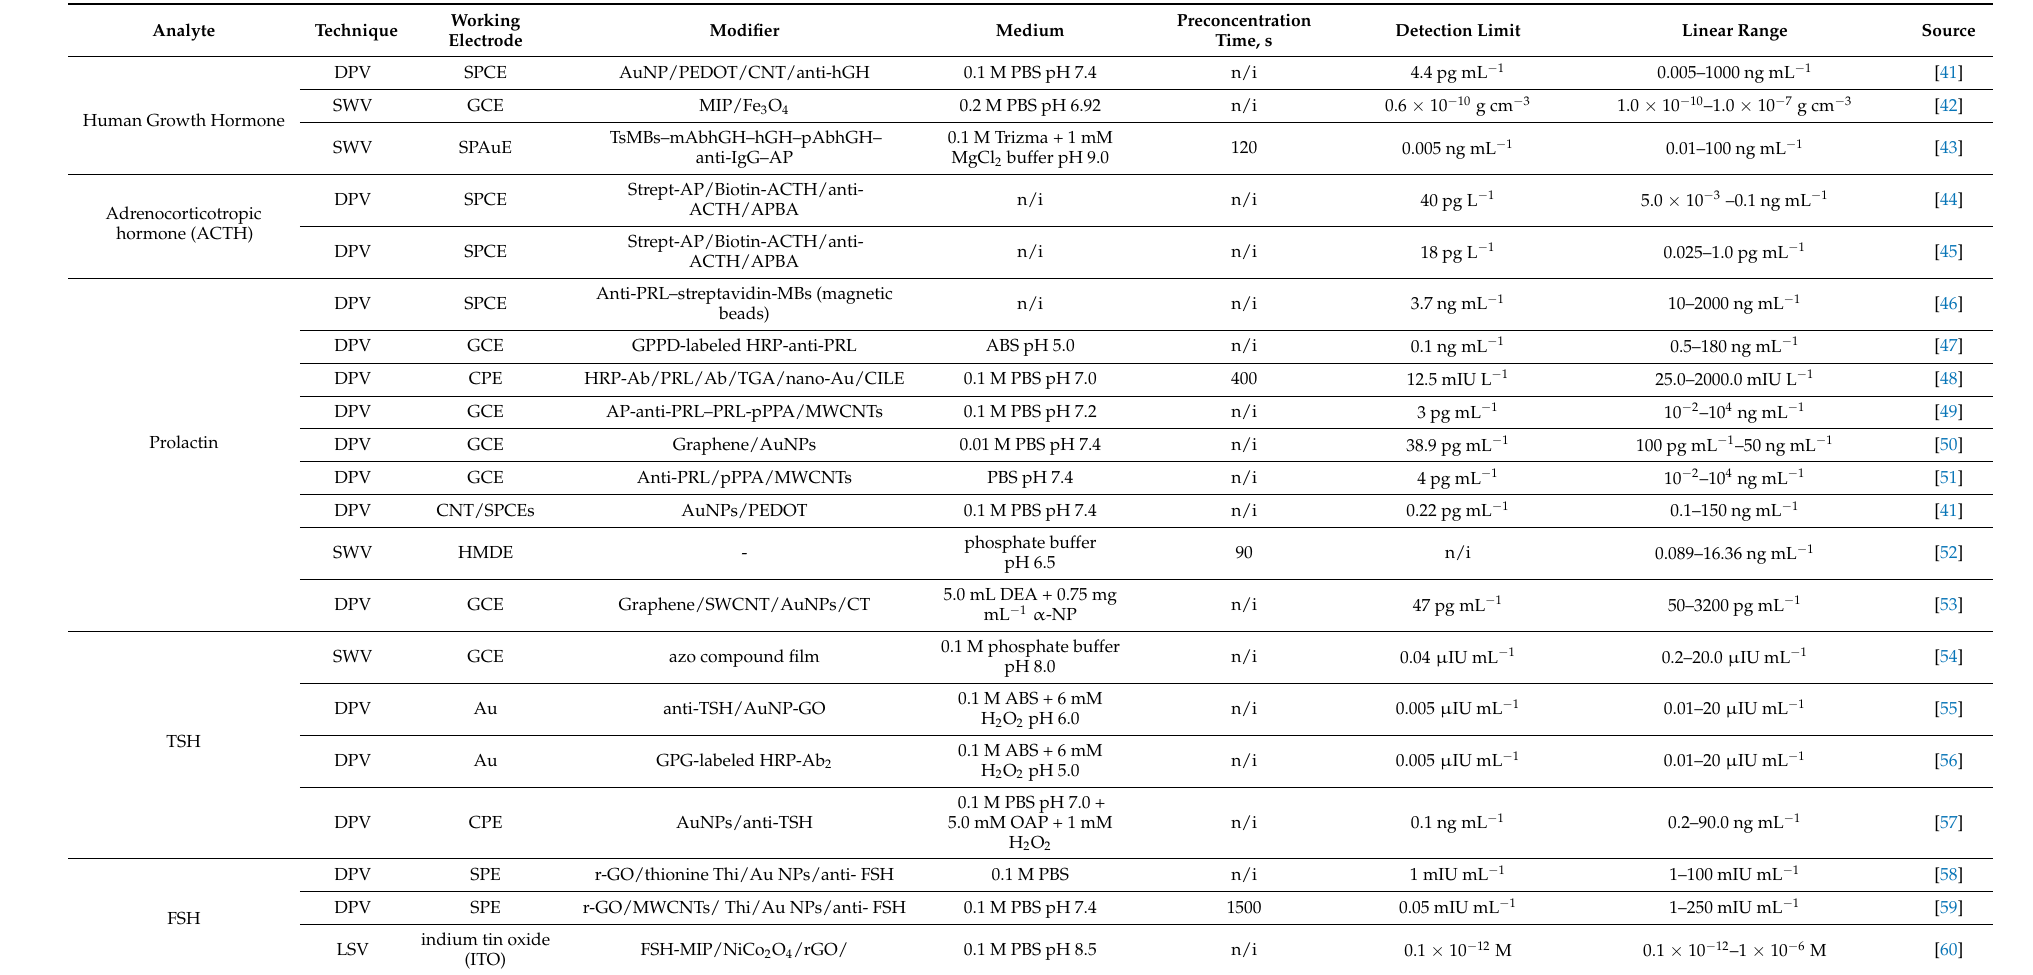
Table 1. Electrochemical methods of pituitary gland hormones